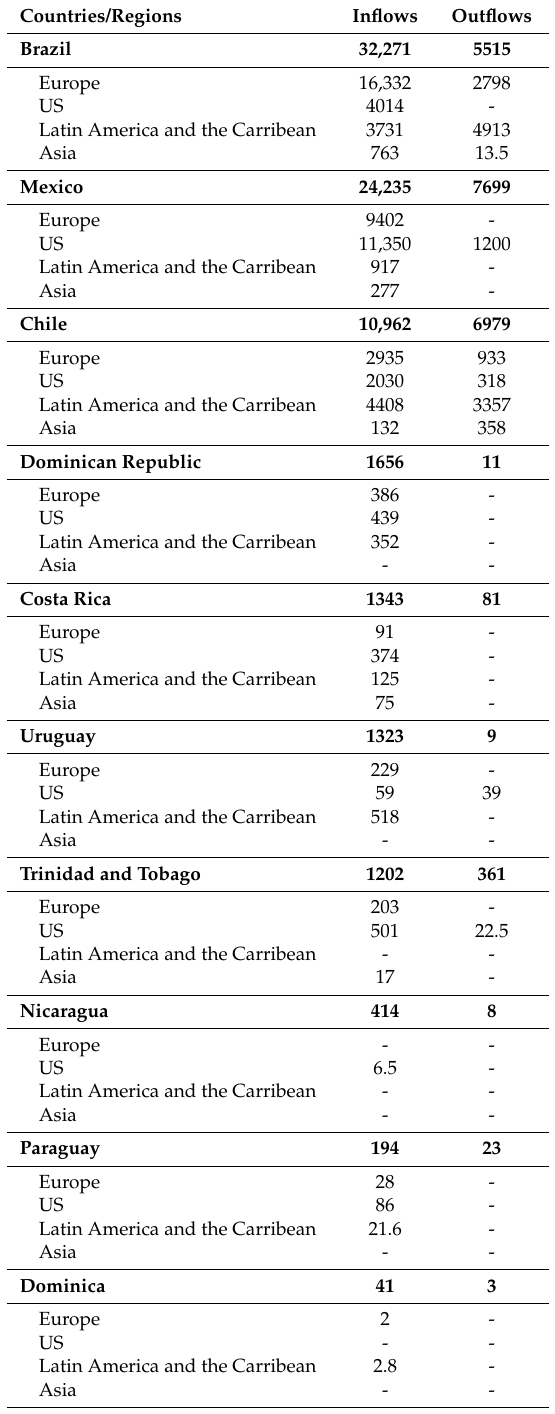
Table 1. Foreign Direct Investment (FDI) inflows to and outflows from selected countries/regions, averages 2001–2012. Data in Millions